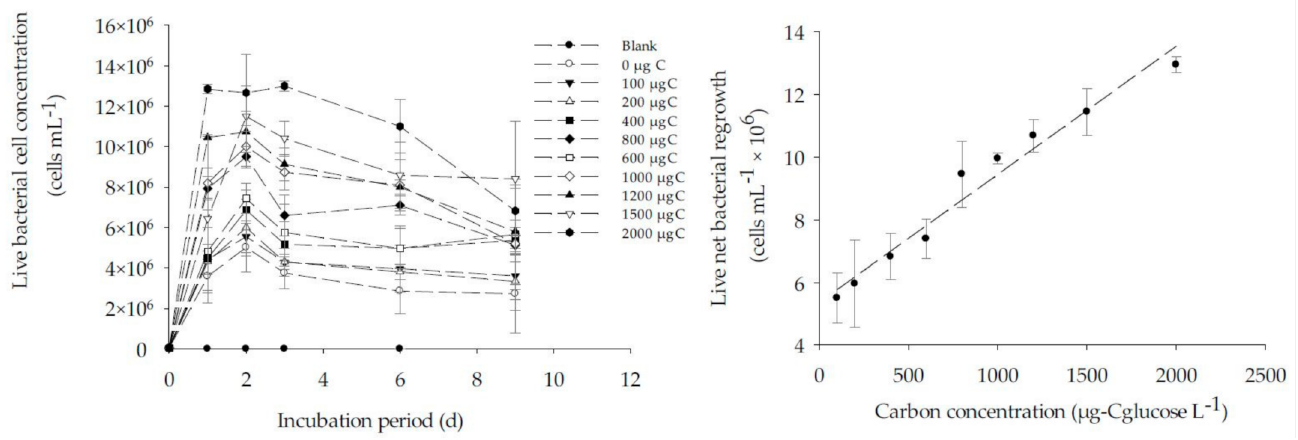
Figure 6. The correlation between the live bacterial net regrowth and carbon concentration (0–2000 µ g-C glucose /L) in real seawater